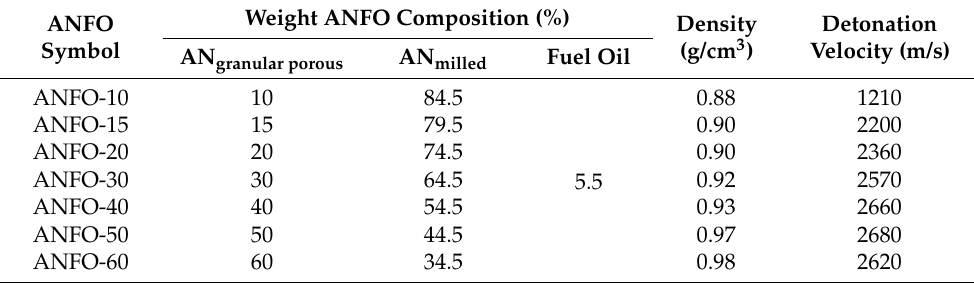
Table 4. Comparison of detonation velocities for different ANFO compositions [29].